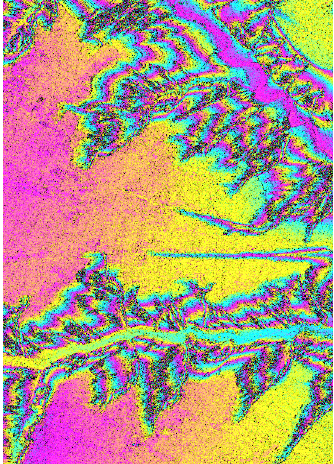
Figure 5. Interferogram after removing flat-earth